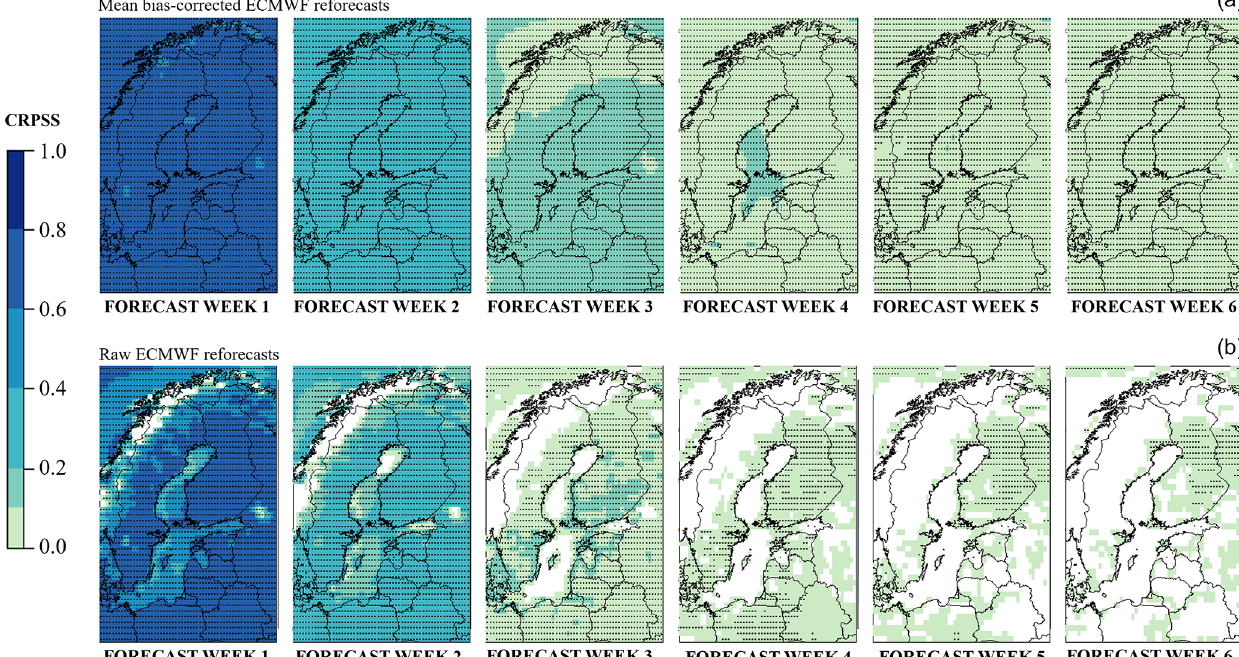
Figure 1. Annual mean of the expected continuous ranked probability skill score (CRPSS) of the weekly mean temperature of the mean bias- corrected (a) and raw (b) ECMWF reforecasts for 1997–2016 using ERA-Interim climatology of 1981–2010 as the reference. The dotted areas represent the 95% level of confidence that the CRPSS is above